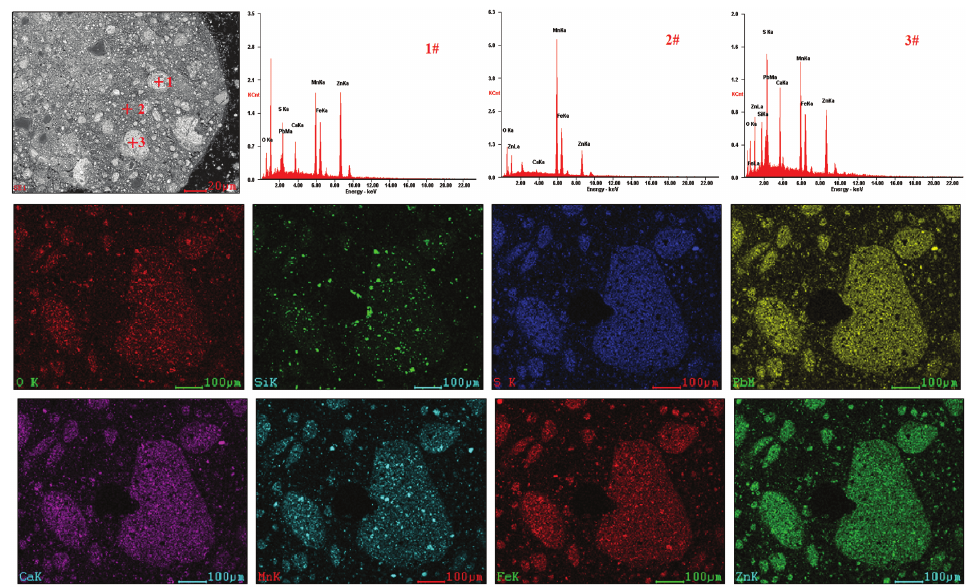
Figure 5: SEM-EDAX analysis of zinc calcine (No. 8).